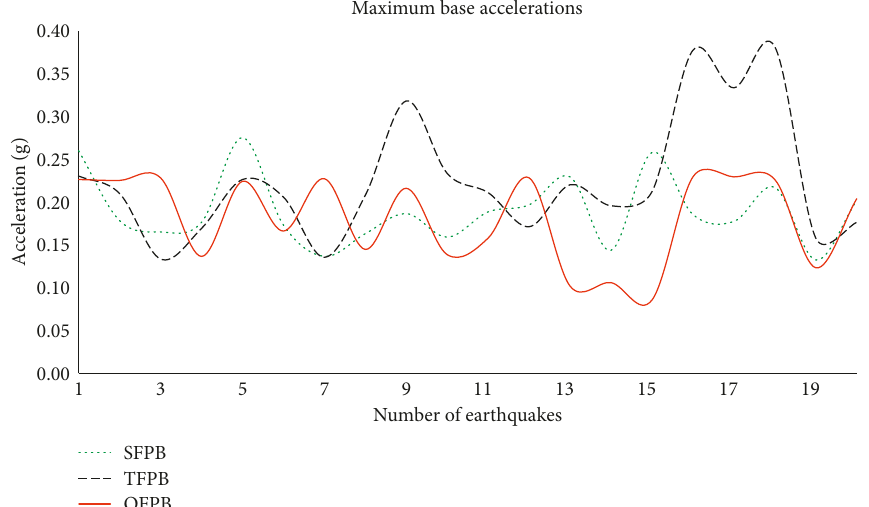
Figure 9: Base accelerations of storage tanks equipped with SFPB, TFPB, and QFPB